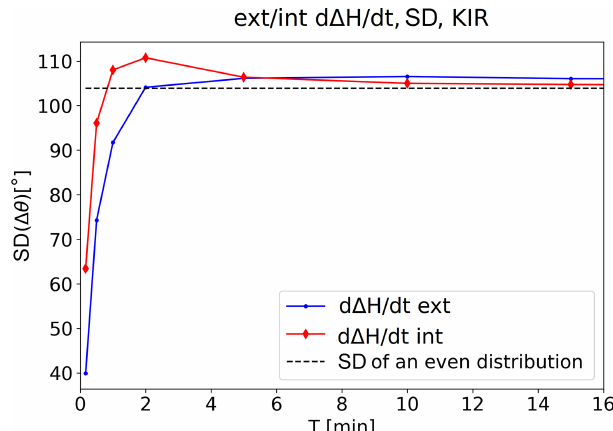
Figure 12. Standard deviations of (cid:49)θ for the external (blue line with dot markers) and internal (red line with diamond markers) d (cid:49) H / d t as a function of T at Kiruna (KIR). Threshold value for chosen events is | d (cid:49) H / d t | > 1nTs − 1